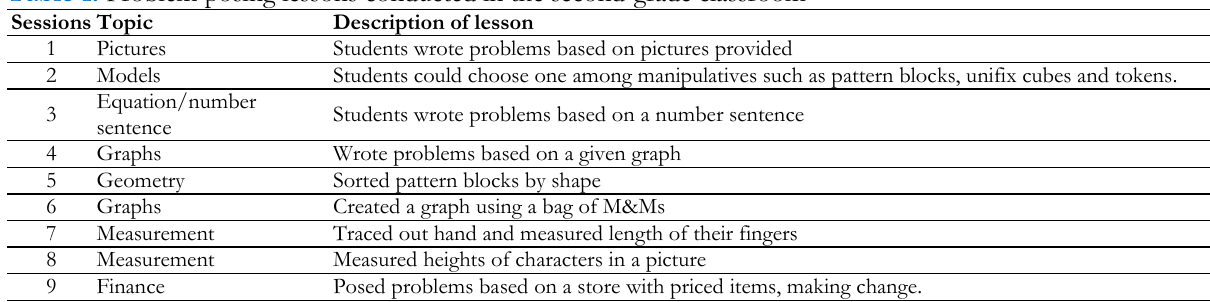
Table 1. Problem posing lessons conducted in the second-grade classroom Sessions